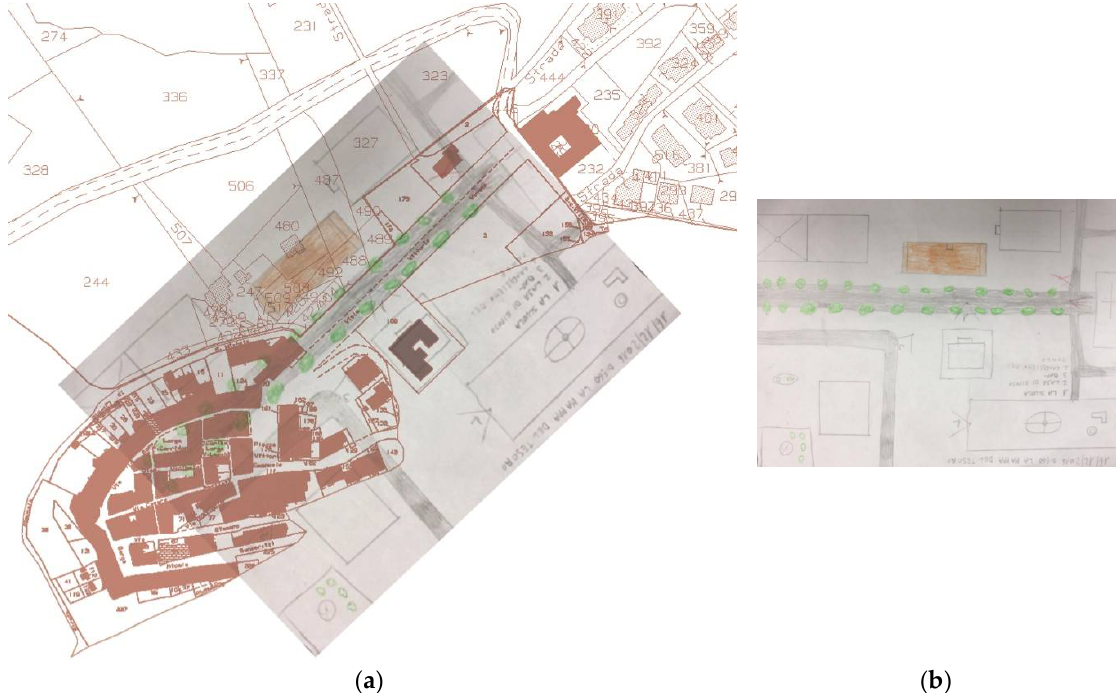
Figure 7. Gualdo from the free-hands memory drawings. ( a ) The cadastral map overlapped to a child drawing (December 2016, graphic processing IP). ( b ) The very specify map of the surroundings area of the school (drawing